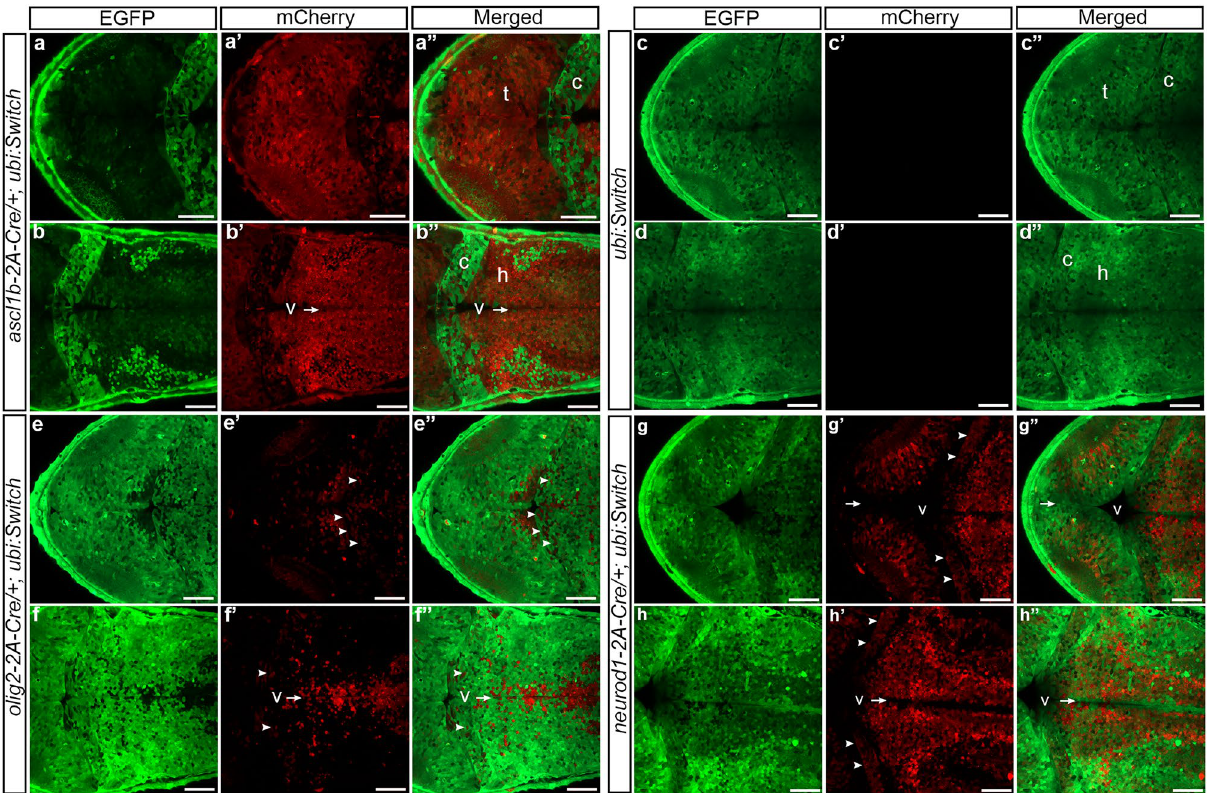
Figure 4. ascl1b-2A-Cre , olig2-2A-Cre and neurod1-2A-Cre Cre recombinase activity in the 3 dpf larval midbrain and hindbrain. F3 or F2 adults were mated to the recombination reporter line ubi:Switch to generate double transgenic embryos. Confocal imaging of ascl1b-2A-Cre; ubi:Switch ( a – a ′′ , b – b ′′ ), control sibling ubi:Switch ( c , d ), olig2-2A-Cre; ubi:Switch ( e – e ′′ , f – f ′′ ) and neurod1-2A-Cre; ubi:Switch ( g – g ′′ , h – h ′′ ) larval midbrain tectum (t), cerebellum (c) and hindbrain (h). Arrows point to the ventricular zone lining the midbrain and hindbrain ventricles (v). Expression of ascl1b-2A-Cre earlier in brain development leads to nearly all descendant neurons expressing mCherry ( a , b ). No switching occurs in the absence of Cre ( c – c ′′ , d – d ′′ ). olig2- 2A-Cre leads to mCherry expression in a subset of cells in the cerebellum (arrowheads), and neural progenitors lining the hindbrain ventricular zone and their descendants ( e , f ). In neurod1-2A-Cre mCherry expression is absent from the ventricular zone (v arrows) but present throughout neurons in the tectum, cerebellum (arrowheads) and hindbrain ( g , h ). Scale bars 50